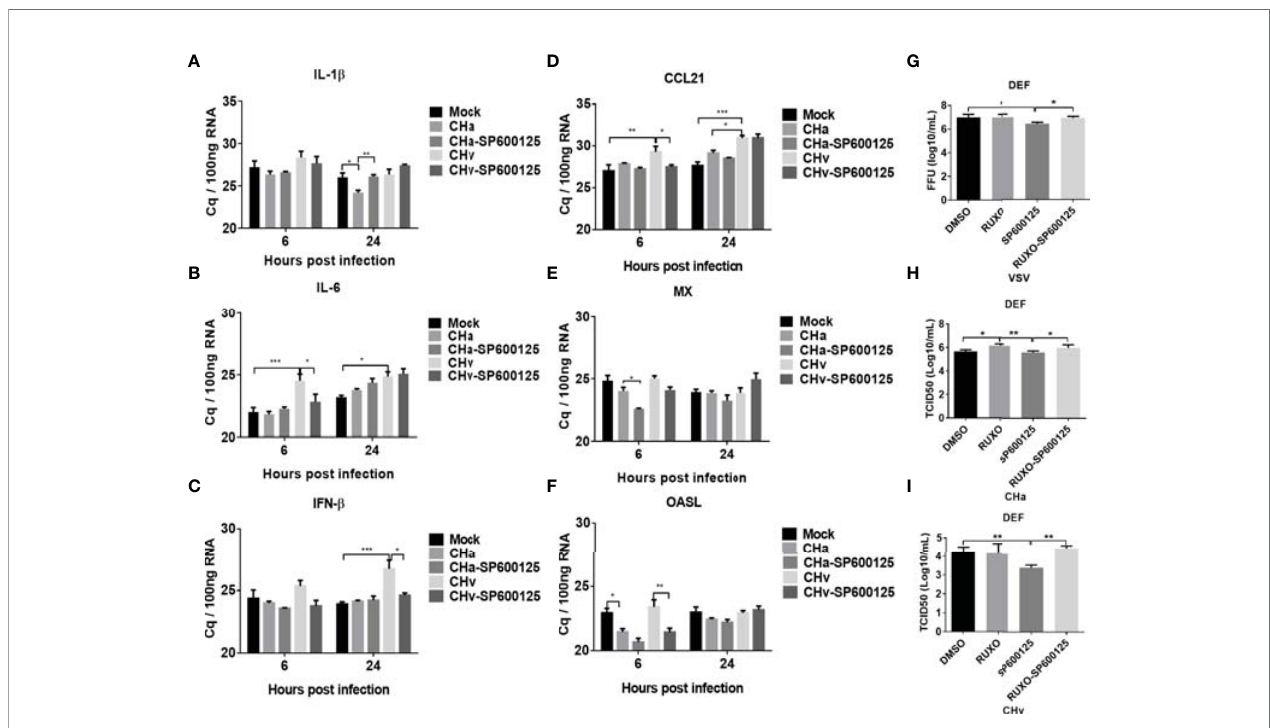
FIGURE 8 | JNK signaling regulates IFN signaling and virus replication. The in fl ammatory signaling affects virus replication in DEF cells. (A-F) DEF cells were pretreated with SP600125 (JNK inhibitor) for 1 h at 10 m M, DMSO as control, then the cells were infected with CHa or CHv strain at 5 MOI for 1 h, then the same concentration of inhibitor was added. The expression level of IL-1 b , IL-6, CCL21, IFN- b , MX, and OASL were tested using RT-qPCR at 6 and 24 h post-treatment. The relative expression was presented as Cq values compared to mock treatment. (G-I) The DEF cells were pretreated with SP600125 (JNK inhibitor) and (or) Ruxolitinib (IFNR inhibitor) for 1 h at 10 m M, then the cells were infected with VSV, CHa or CHv strain at 1 MOI for 1 h, then the same concentration of inhibitor was added. The cell culture supernatant was collected and the viral titer was determined on DEF cells. “ * ” was considered signi fi cant difference ( p < 0.05); “ ** ” was considered highly signi fi cant difference ( p < 0.01); “ *** ” was considered highly signi fi cant difference ( p <